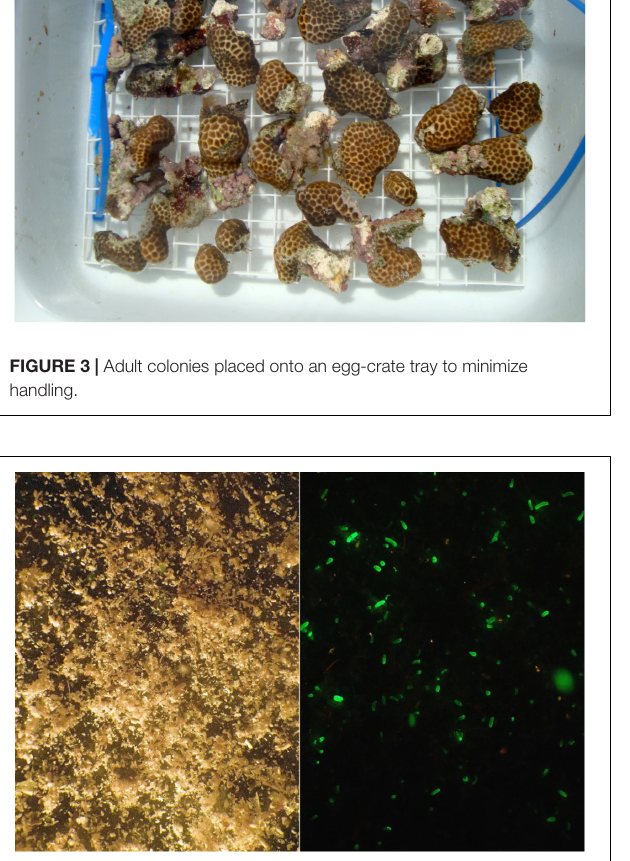
FIGURE 4 | Material from the collection container retained by a 30- µ m mesh. (Left) Full spectrum halogen light. (Right) Fluorescent blue light, photograph taken through a yellow barrier filter. Both photos depict exactly the same frame. The GFP helps to spot the larvae among the detritus and other